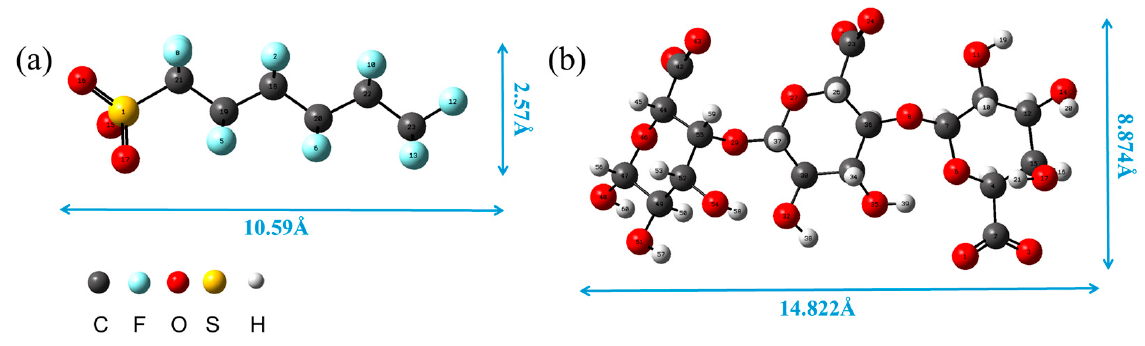
Figure 4. Structure optimization diagram of ( a ) PFHxS and ( b ) SA .